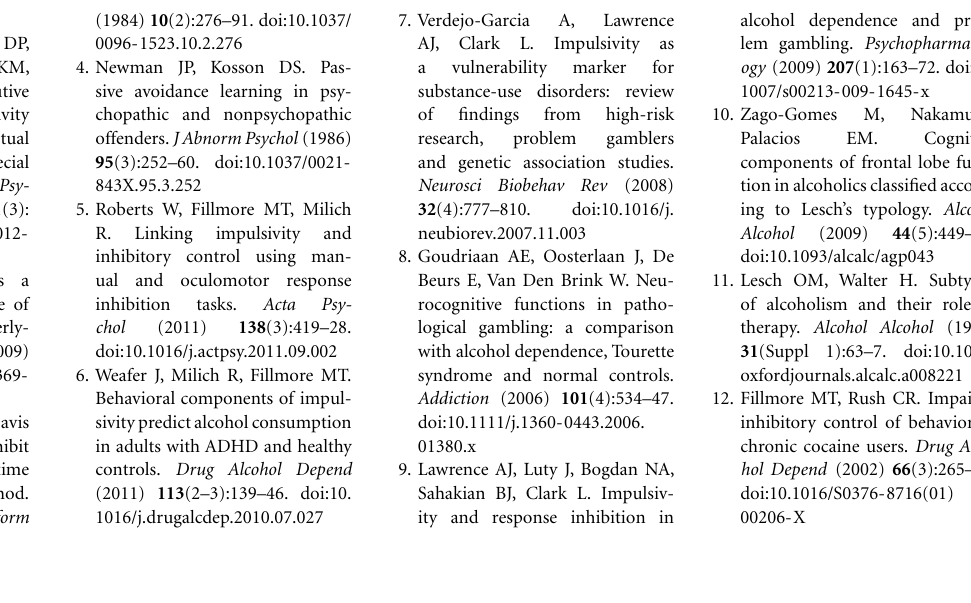
FIGURE 1 | Environmental triggers and psychological processes that underlie changes in state disinhibition, and their influence on substance use . Individuals have a stable capacity for inhibitory control, but a component of this capacity appears to fluctuate in response to environmental triggers and psychological processes. If individuals are in a disinhibited state, they are more likely to engage in substance use, or relapse to substance use after a period of abstinence. If individuals